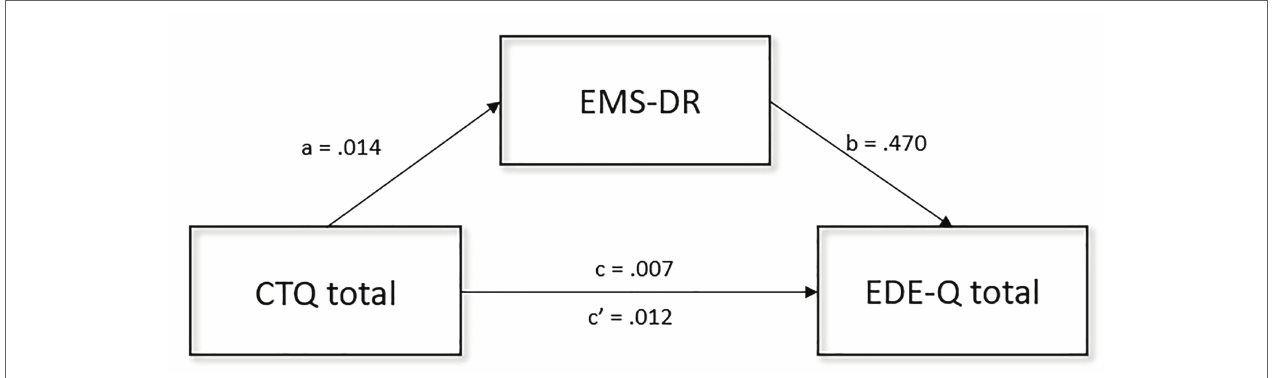
FIGURE 1 | Graphical representation of the mediation analysis performed between CTQ total score (independent variable), EDE-Q total score (dependent variable), and EMS-DR (mediator). Confirmatory Sobel test confirmed the mediation effect represented ( t = 2.152, SE = 0.003, p = 0.031). EDE-Q, eating disorder examination questionnaire; EMS-DR, early maladaptive schema disconnection and rejection; CTQ, childhood trauma questionnaire; a, b, c, and c ' are path